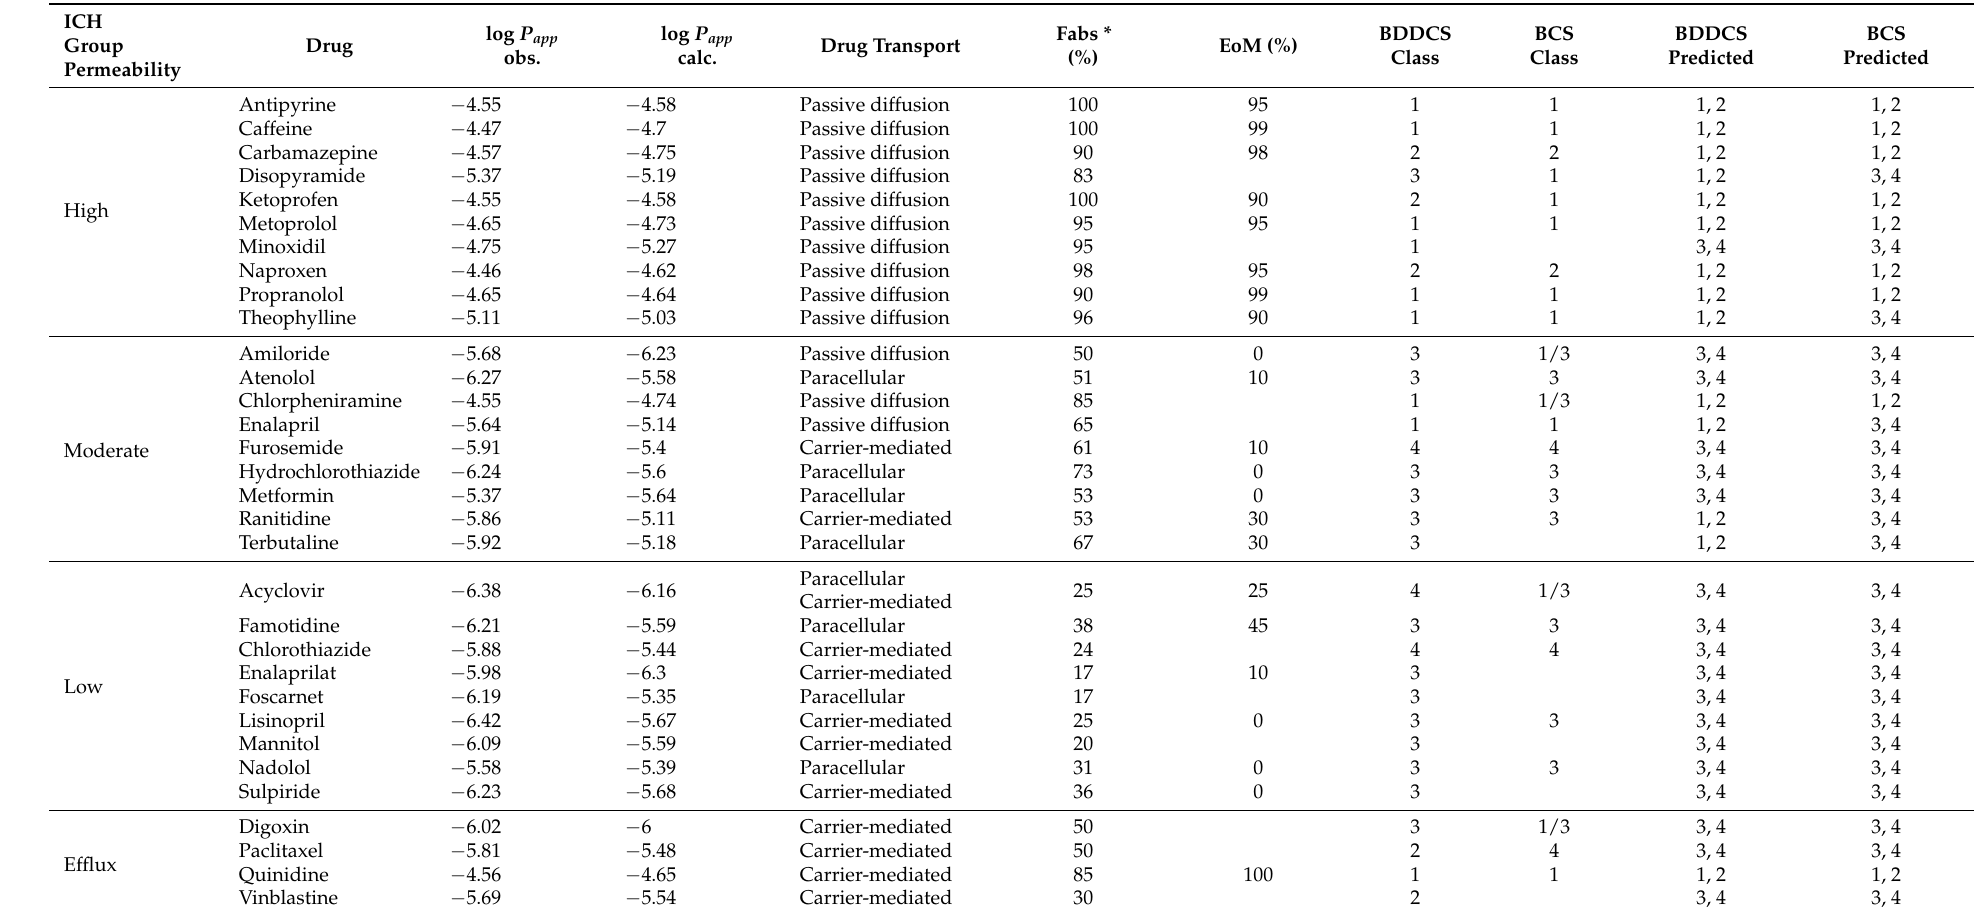
Table 3. Model outputs for 32 drugs included in the ICH list to validate and standardize Caco-2 permeability